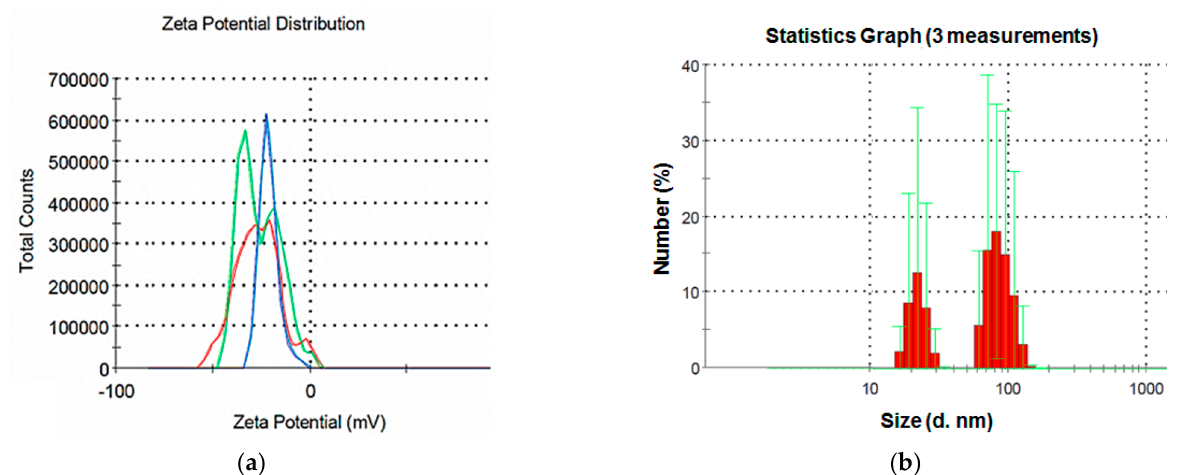
Figure 2. The CuO-NP suspension ( a ) zeta potential and ( b ) particle size distribution.